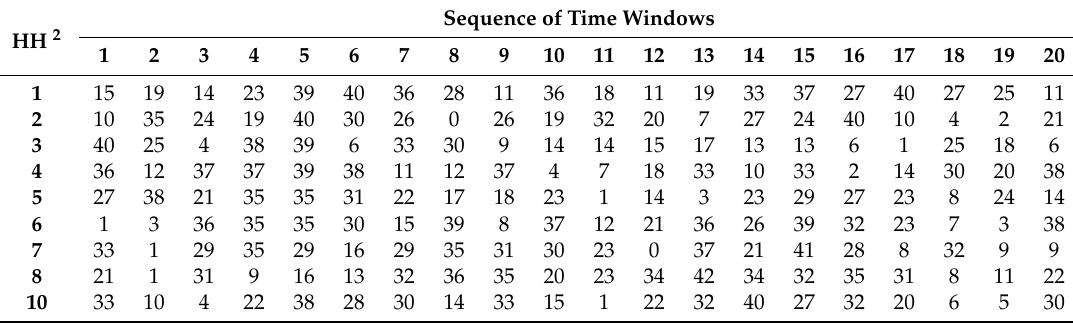
Table 2. Input parameters of scenarios: Generated volume of waste in households 1 . HH 2